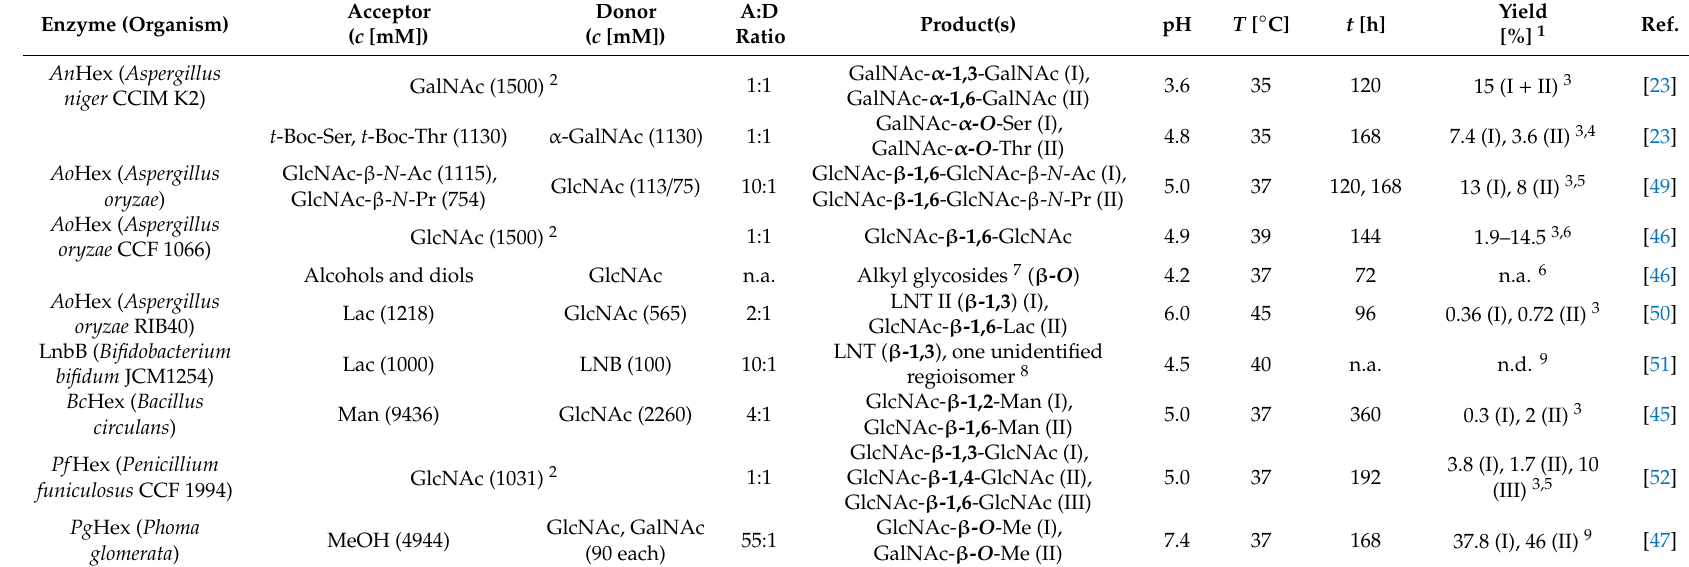
Table 1. Synthetic approaches using GH20 enzymes in reverse hydrolysis reactions. New bonds are highlighted in bold. Enzyme (Organism) An Hex ( Aspergillus niger CCIM K2)